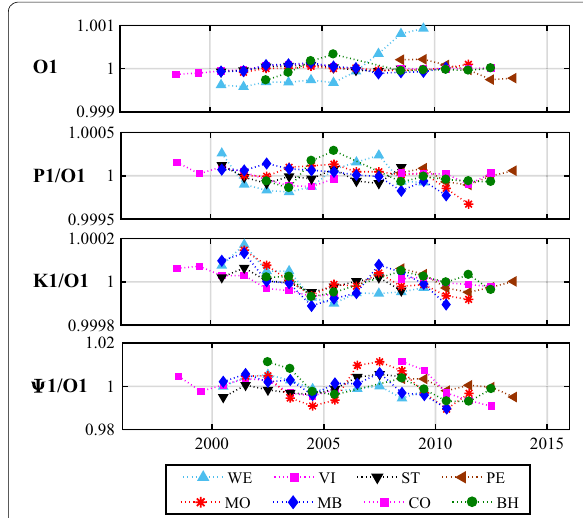
Fig. 7 Amplitude factor of diurnal waves in the first station class. Amplitude factors of P1, K1 and ψ1 waves are normalized by the one of the O1 waves. All amplitude factors are then divided by their mean value for the convenience of comparison